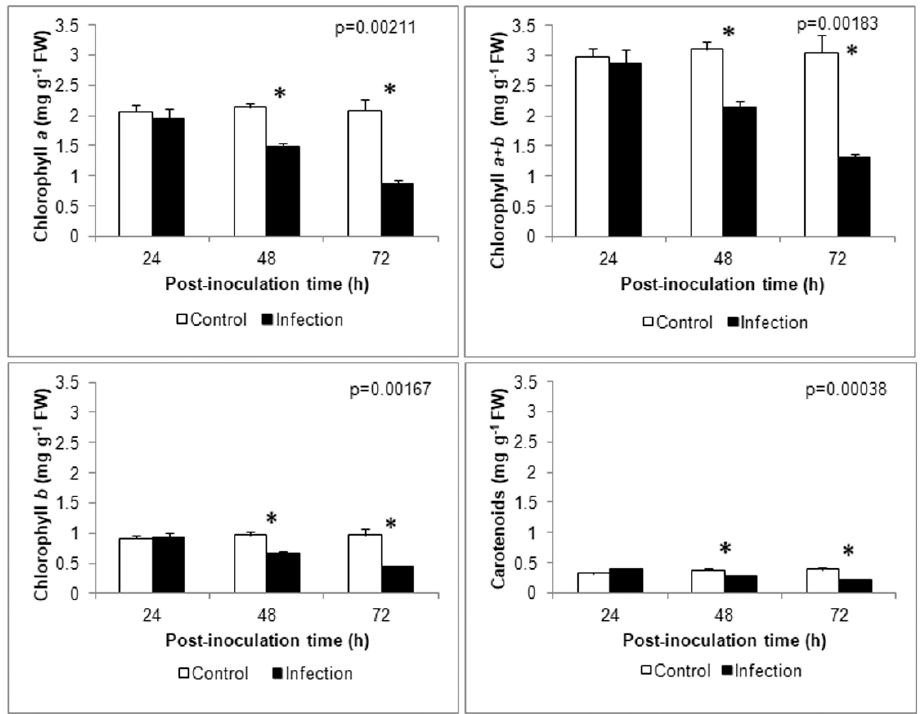
Figure 9. Time-course analysis of photosynthetic pigment content. The means ± SE were obtained in 3 independent experiments ( n = 3). Asterisks indicate significant differences between control and infection at each time point according to the Duncan test (* p < 0.05).